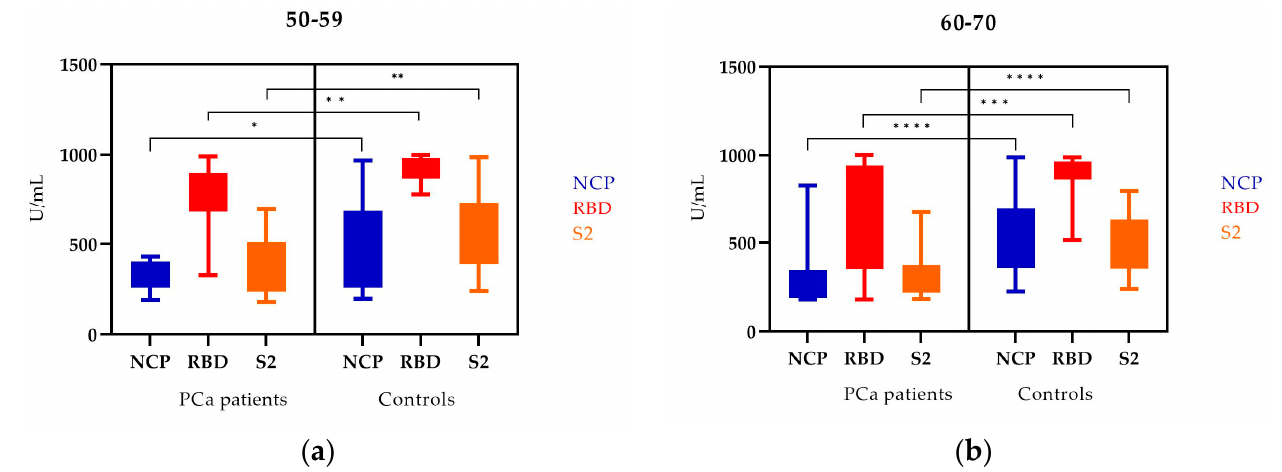
Figure 2. The levels of NCP, RBD, and S2 IgG antibodies in PCa patients and controls by age: ( a ) 50–59, ( b ) 60–70; Mann–Whitney U test; median (min–max); * statistically significant (10 − 1 ); ** statistically significant (10 − 2 ); *** statistically significant (10 − 3 ); **** statistically significant (10 − 4 ). Analyzing the 60–70 age group, we also observed statistically significant differences in the levels of all types of antibodies. The levels were higher in controls than in PCa patients (Figure 2b). Table 3. The levels of NCP, RBD, and S2 IgG antibodies (U/mL) in PCa patients and controls by age.